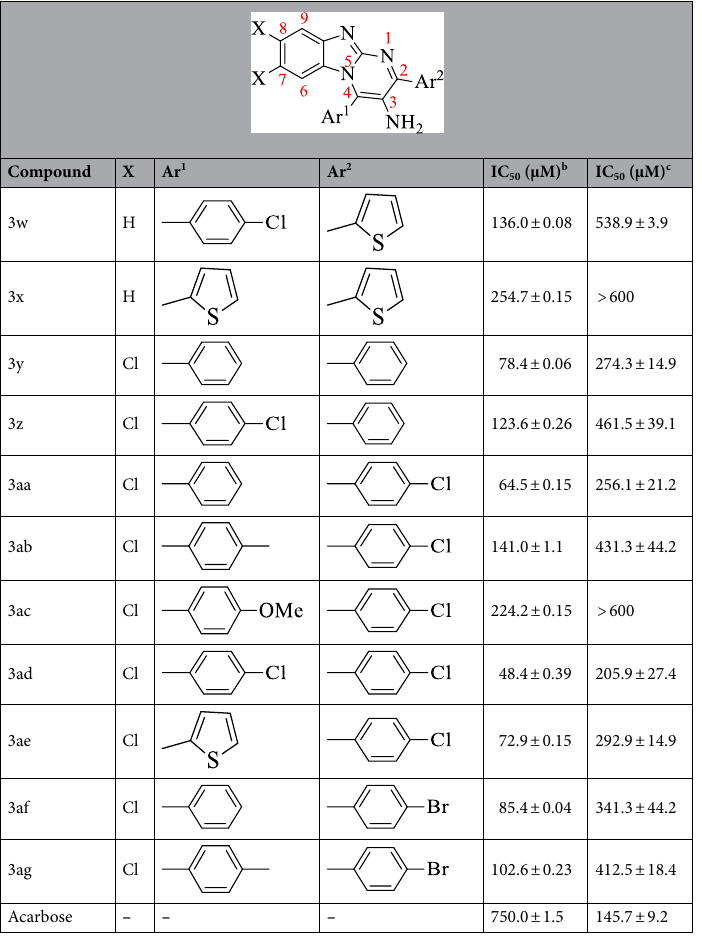
Table 1. Substrate scope and α-glucosidase inhibitory activity of compounds 3a–ag . Values are the means of three replicates ± standard deviation (SD). b The activity against Saccharomyces cerevisiae α-glucosidase. c The activity against rat small intestine